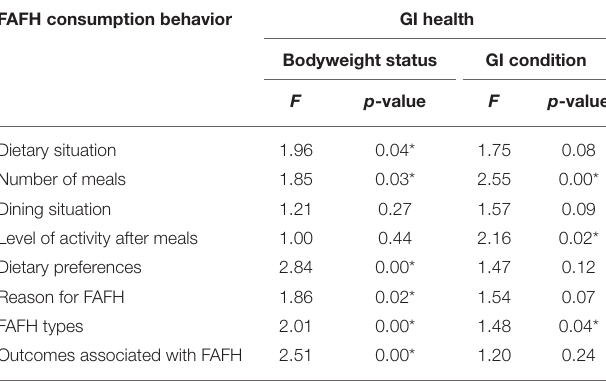
TABLE 5 | Association of GI health with FAFH consumption behavior ( N =